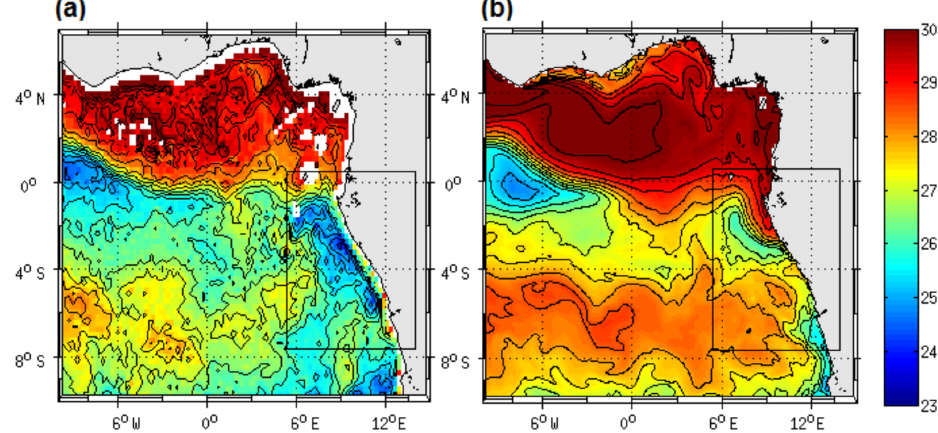
Figure 2. Map of the sea surface temperature ( ◦ C) on 12 May 2005 from 3-day average TMI data (a) and from the 2-day average model output (b) . Note that for the model it corresponds to the 11–12 May average, whereas for TMI data it is the 10–12 May average. The black square indicates the Cape Lopez region (called the